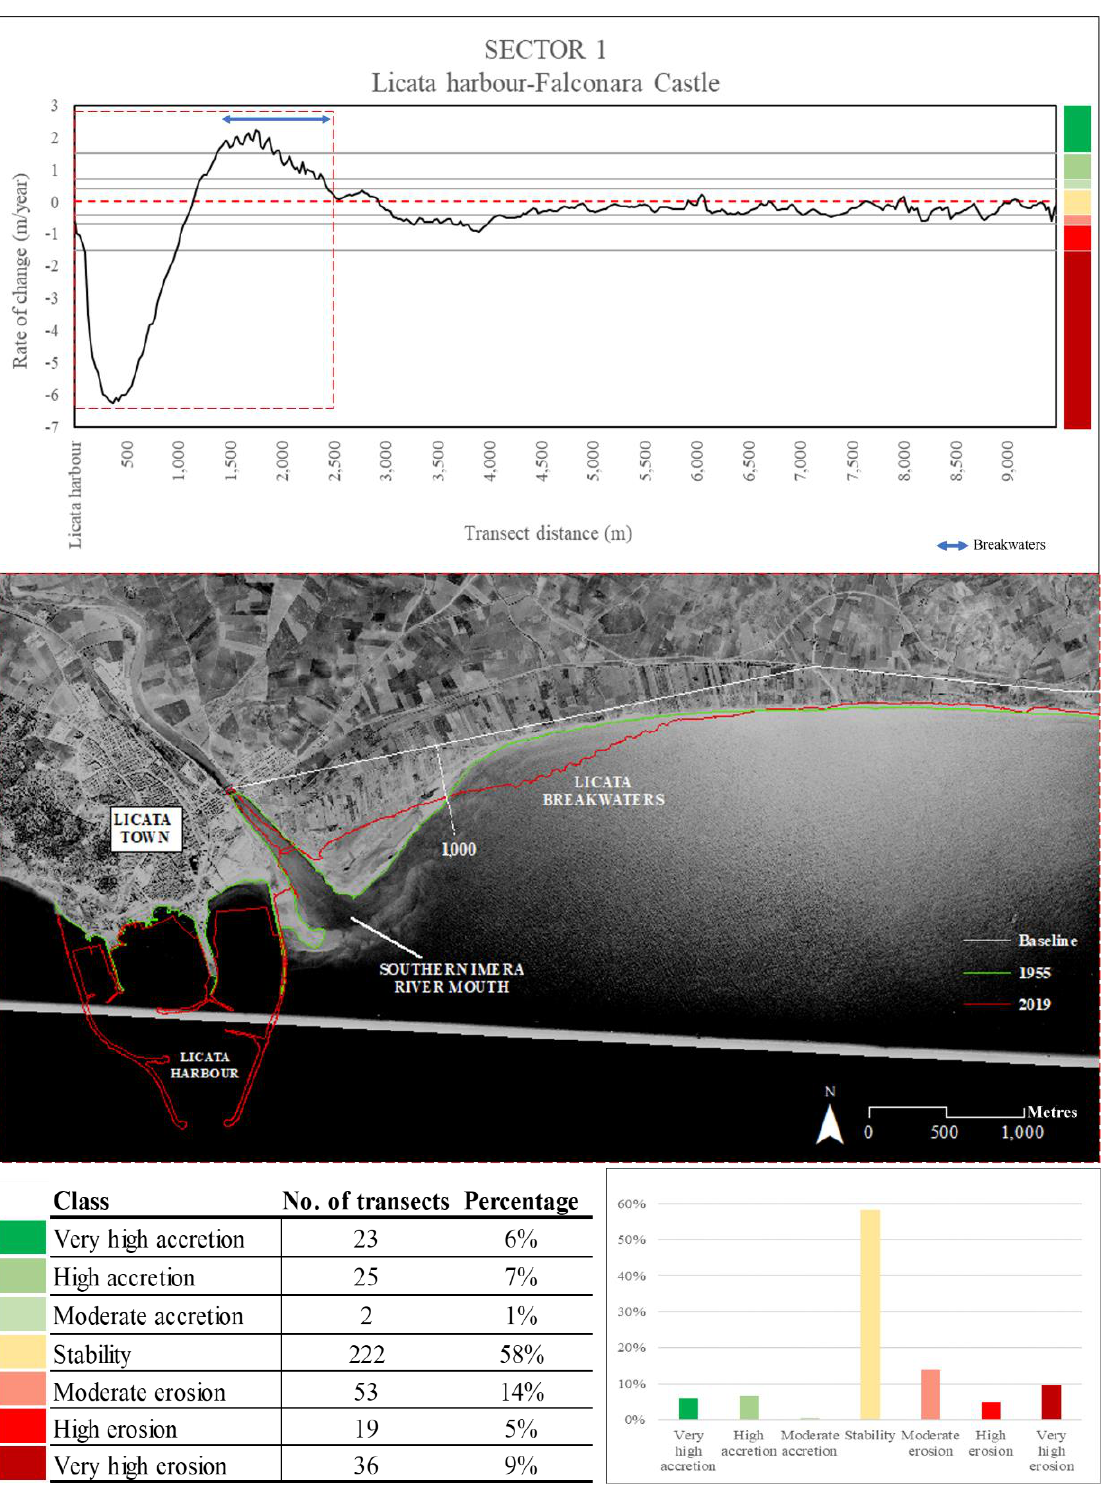
Figure 3. Rates of change within sector no. 1 over the long-term period (1955–2019). In total, 58% of the data falls within the stability state range, especially observed in the coastal area at a distance between 3 and 10 km from the harbour (highest negative WLR = −6.25 m/year), but significant sediment deposition was recorded between 1955 and 1989 where a set of breakwaters have been emplaced.